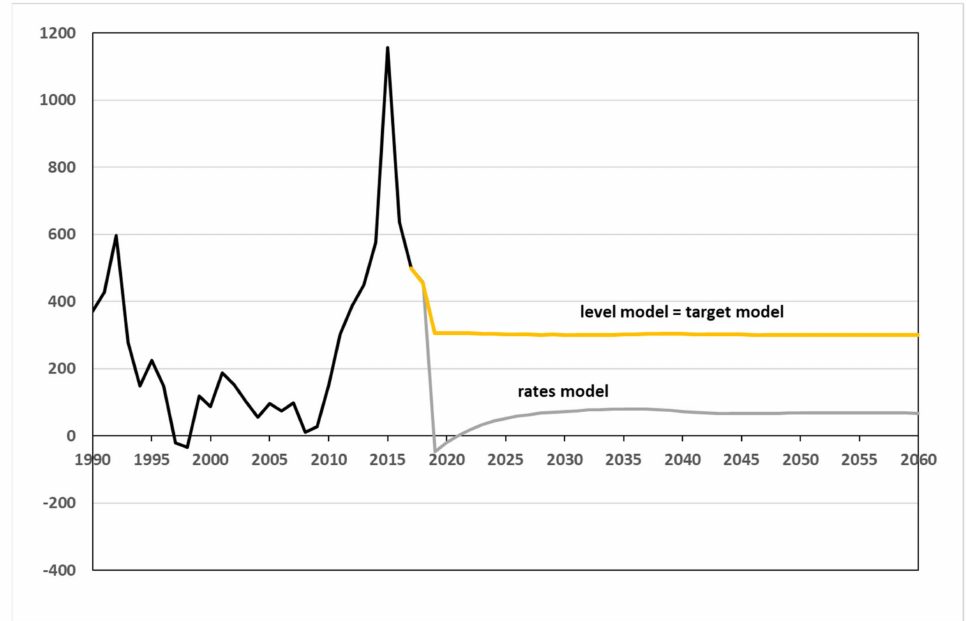
Figure 6. Migration balance of the non-German population until 2060 (in k)—simulation results from 2019 onwards. (Sources: [57]; own computation and